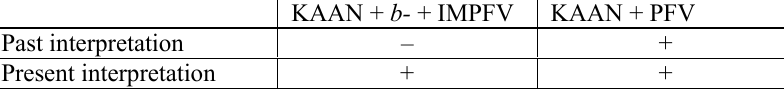
Table 4 : Counterfactual consequents and their temporal